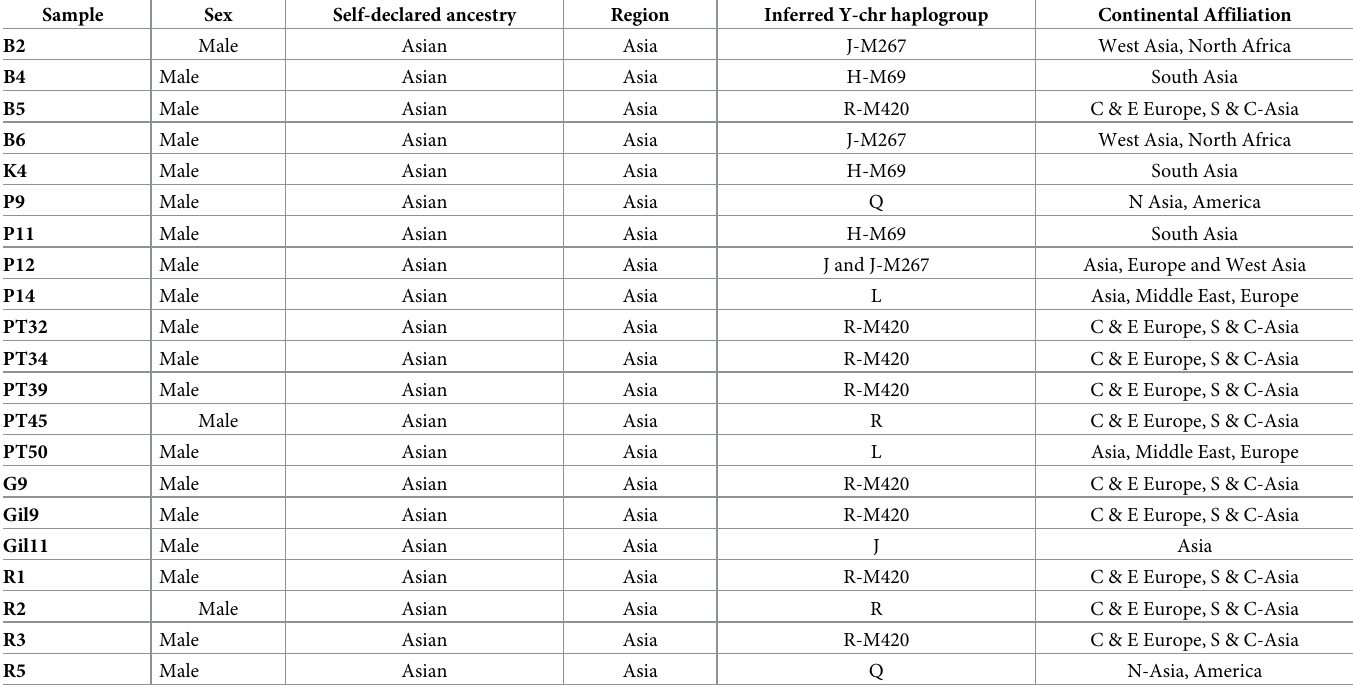
Table 4. Summary of Y-chromosome haplogroup results from twenty-one male samples.